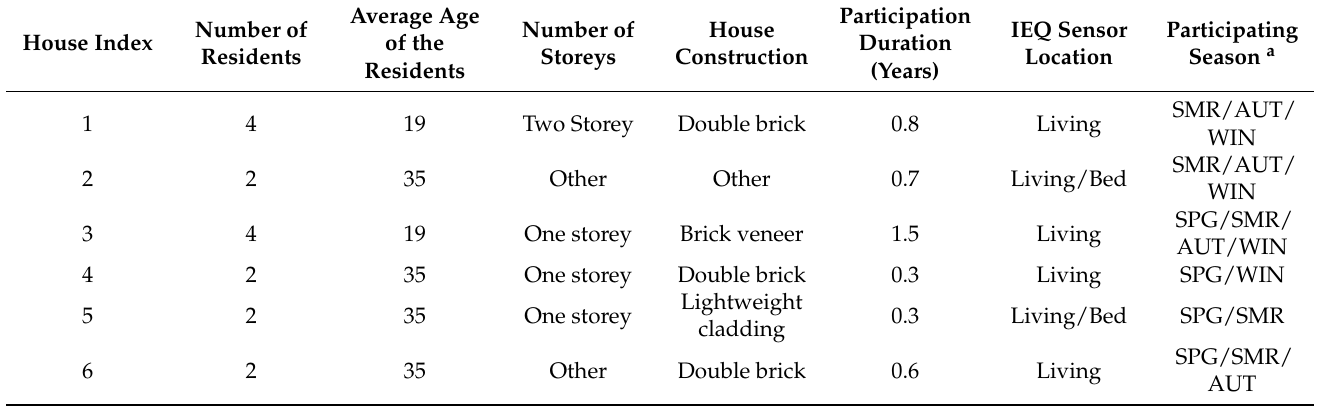
Table 1. Description of the sample of Sydney region residents and characteristics of their